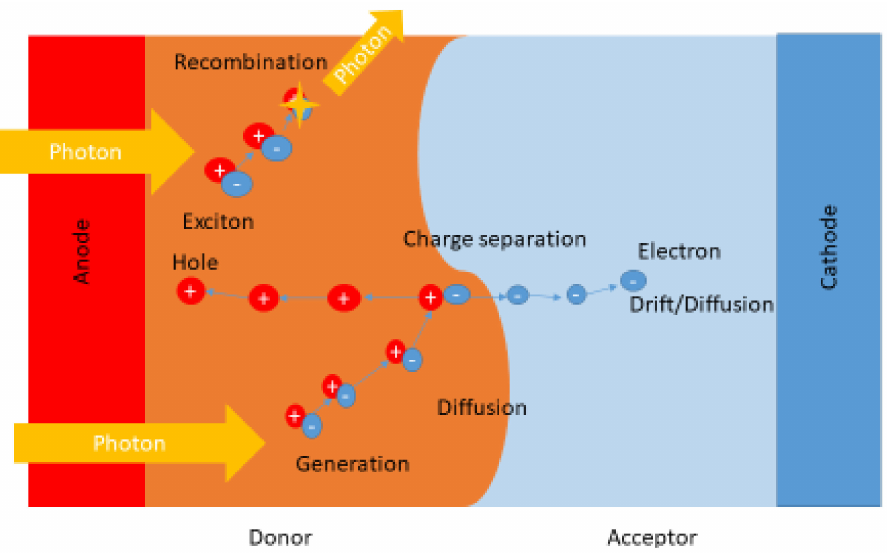
Figure 3. Illustrate the principle of charge separation within a solar cell